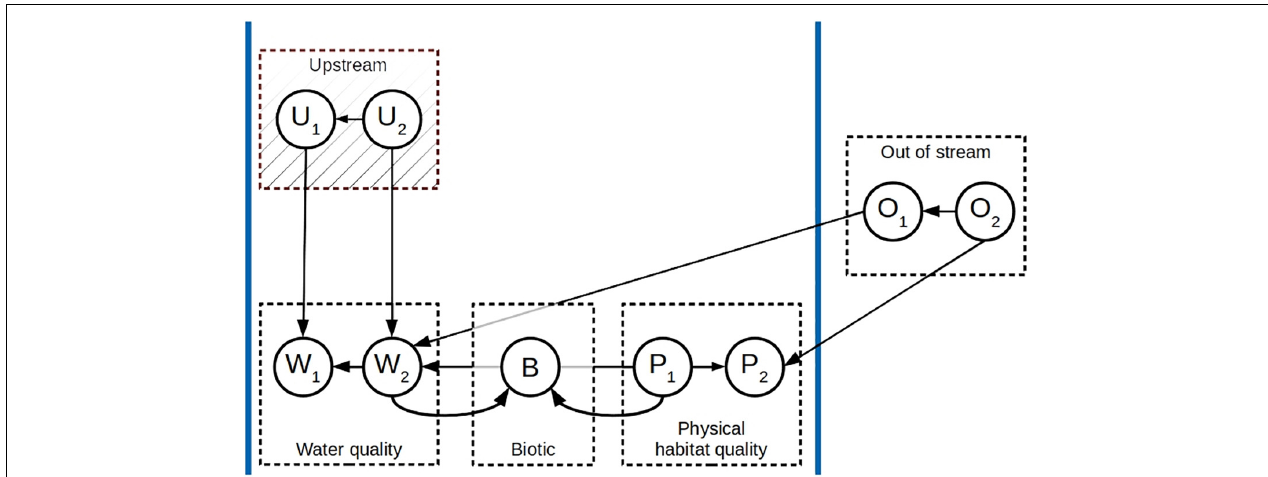
FIGURE 2 | Exemplary schematic of a generative model of ecological relationships in flowing freshwater ecosystems, including the different groups of variables (water quality, physical habitat quality, biotic, out of stream, and upstream water quality) and their relationships. In this example, each group of variables contains two variables, indicated by their subscript, apart from the biotic variable group which consists of a single variable. The variable set U consists of the variables in the set W measured at the locations upstream.